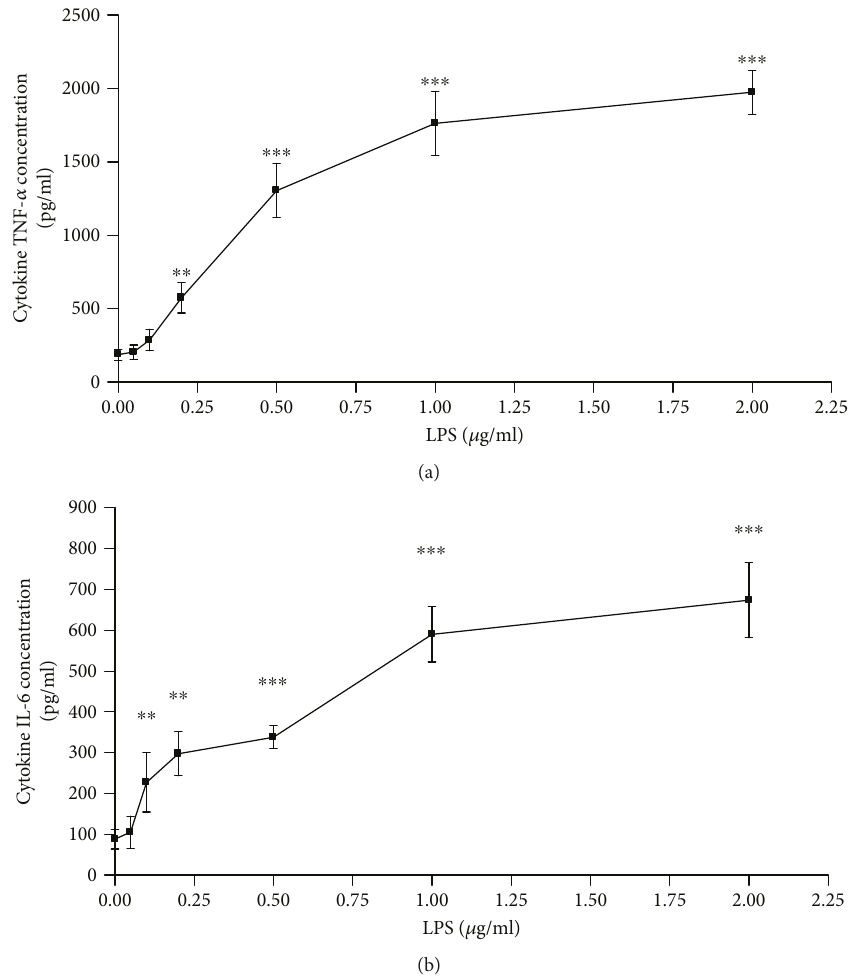
Figure 1: LPS promotes the release of in fl ammatory factors from RAW264.7 cells. (a) RAW264.7 cells were cultured in the presence of LPS (0, 0.05, 0.10, 0.20, 0.5, 1.0, or 2.0 μ g/ml) for 24 h. The concentrations of TNF- α were determined using ELISAs ( n = 4 ). (b) RAW264.7 cells were cultured in the presence of LPS (0, 0.05, 0.10, 0.20, 0.5, 1.0, or 2.0 μ g/ml) for 24h, and the concentrations of IL-6 were determined using ELISAs ( n = 4 , ∗∗ P < 0 01 , ∗∗∗ P < 0 001 versus the control